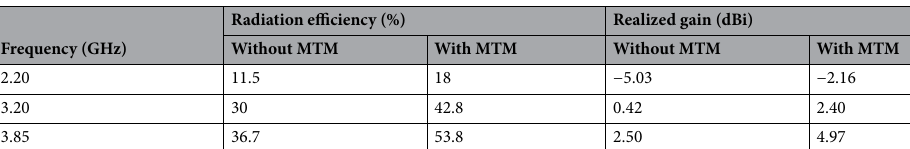
Table 1. Realized gain and radiation efficiency of the antenna with and without metamaterial structure in proximity to the head phantom.